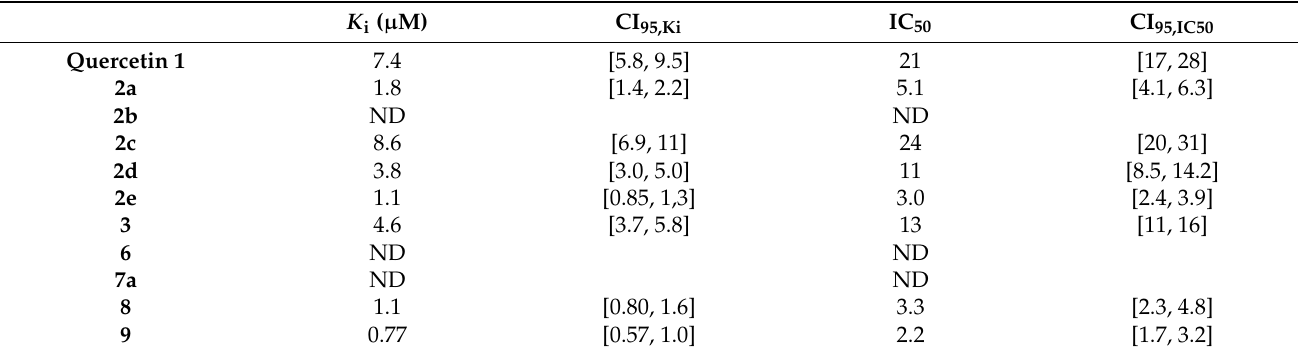
Table 3. K i and IC 50 values of the tested compounds a